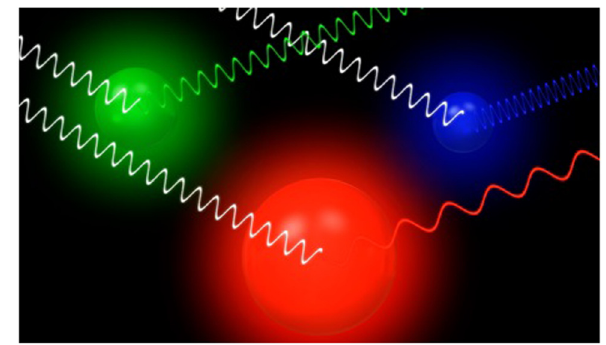
Figure 3: QD tune